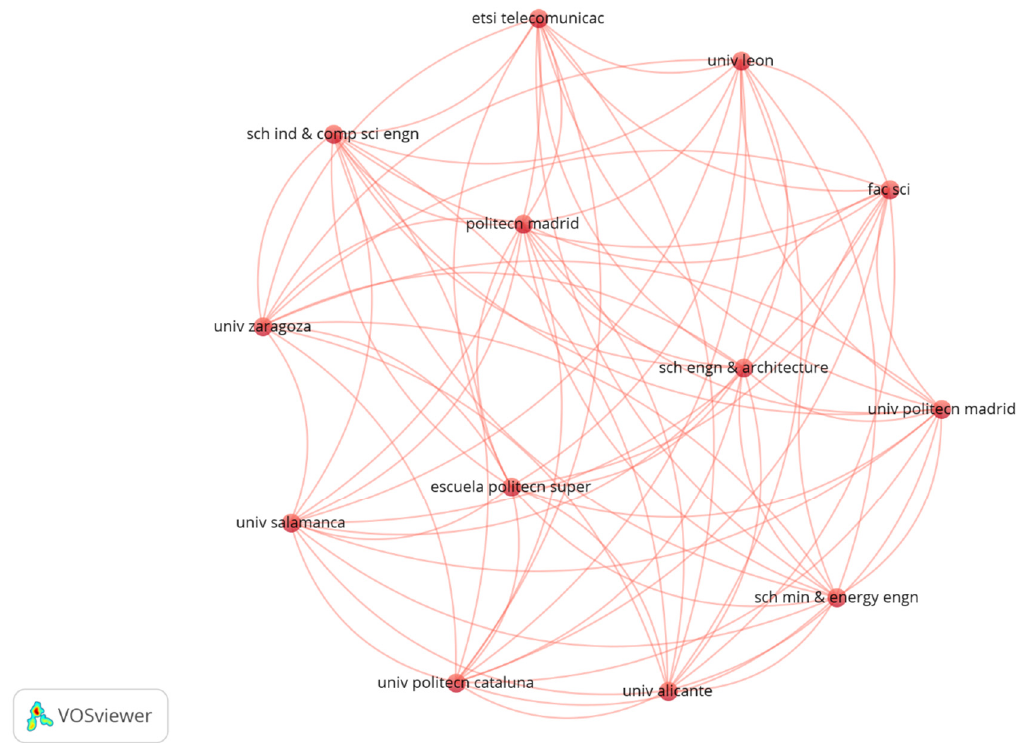
Figure 4. Networked organisations.